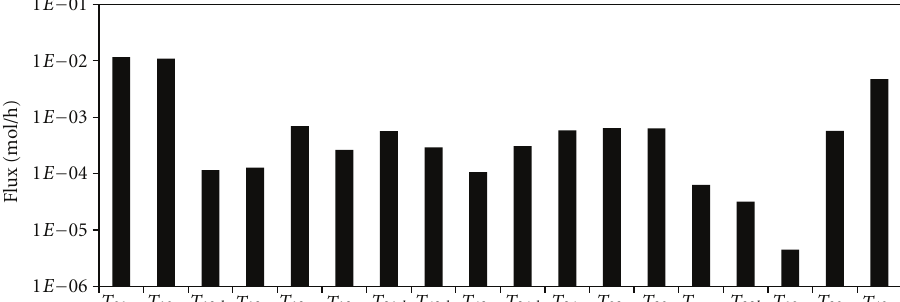
Figure 4: α -HCH fluxes in and out of the Lake Chaohu area and between the adjacent compartments. T 01 t : air advection flows into the area; T 10 t : air advection flows out of the area; T 12 d : di ff usion from air to water; T 12 p : dry deposition from air to water; T 12 w : wet deposition from air to water; T 12 r : rain scavenging; T 21 d : di ff usion from water to air; T 42 d : di ff usion from sediment to water; T 42 r : resuspension from sediment to water; T 24 d : di ff usion from water to sediment; T 24 s : sedimentation from water to sediment; T 02 t : water advection flows into the area; T 20 t : water advection flows out of the area; T 02 h : locative wastewater discharge; T 23 h : industry and agriculture water usage; T 10 m : degradation in air; T 20 m : degradation in water; T 40 m : degradation in sediment.